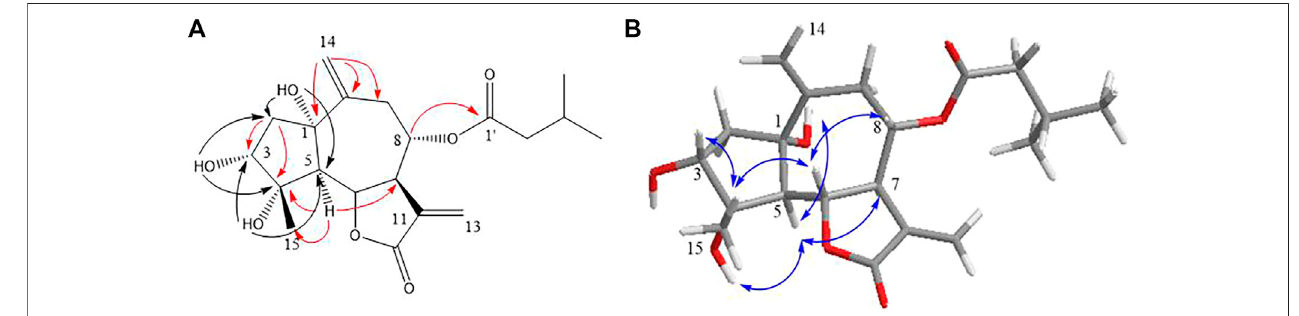
FIGURE 1 | Key HMBC (A) and NOESY (B) correlations of compound 1